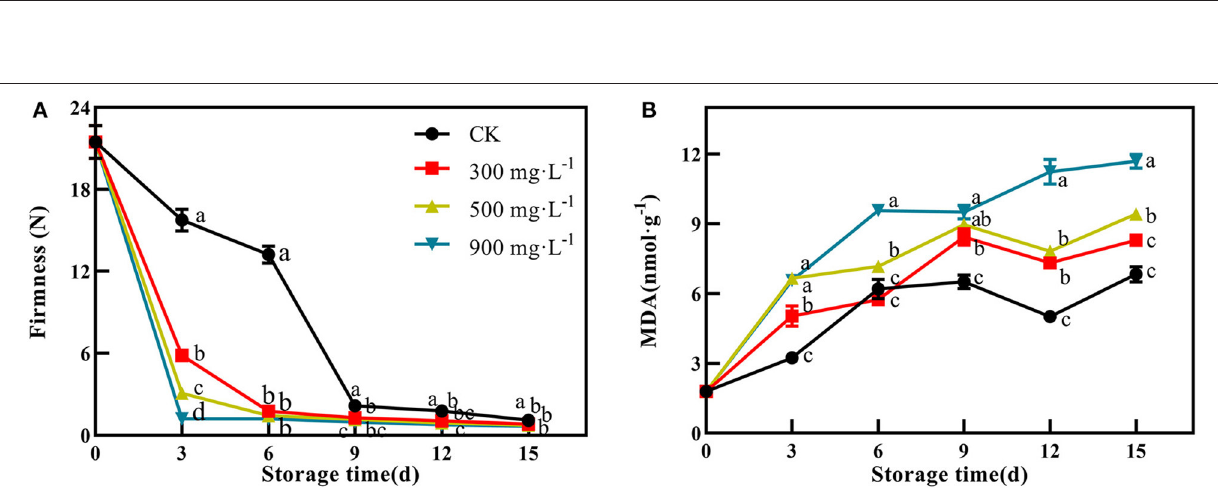
Frontiers in Nutrition |